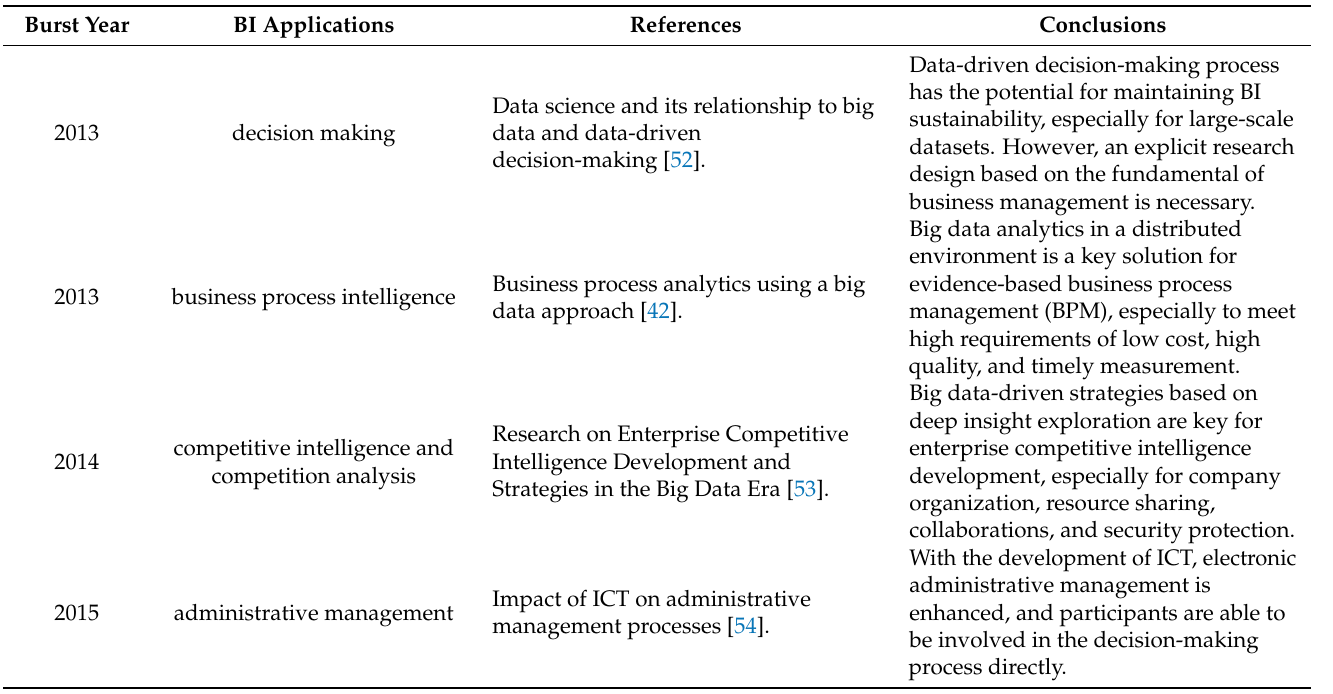
Table 9. Developing trends of BI applications based on big